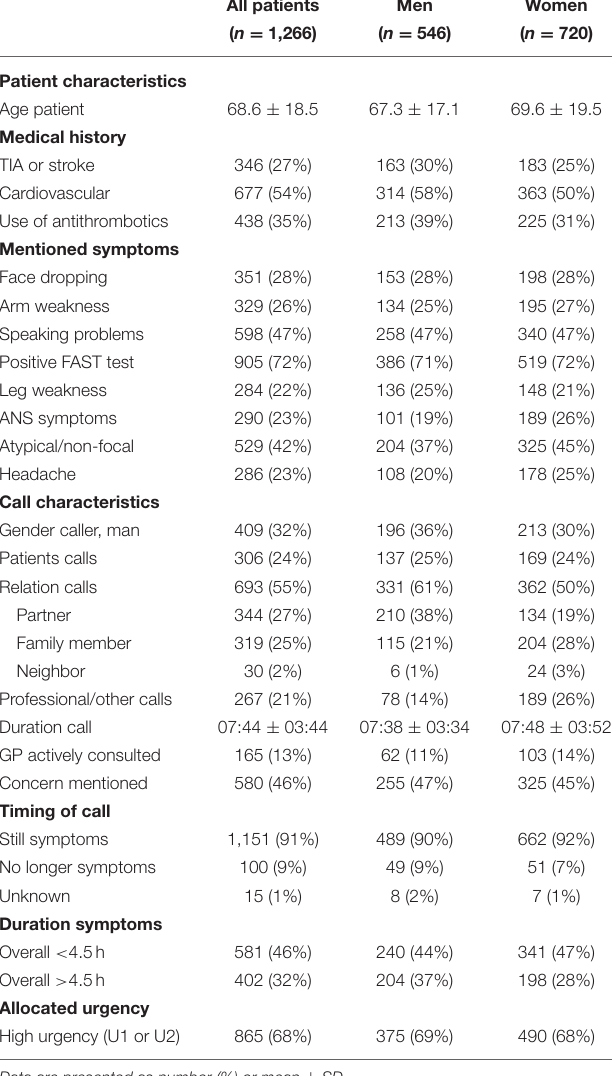
TABLE 1 | Patient and call characteristics by gender of subjects with suspected TIA/stroke.